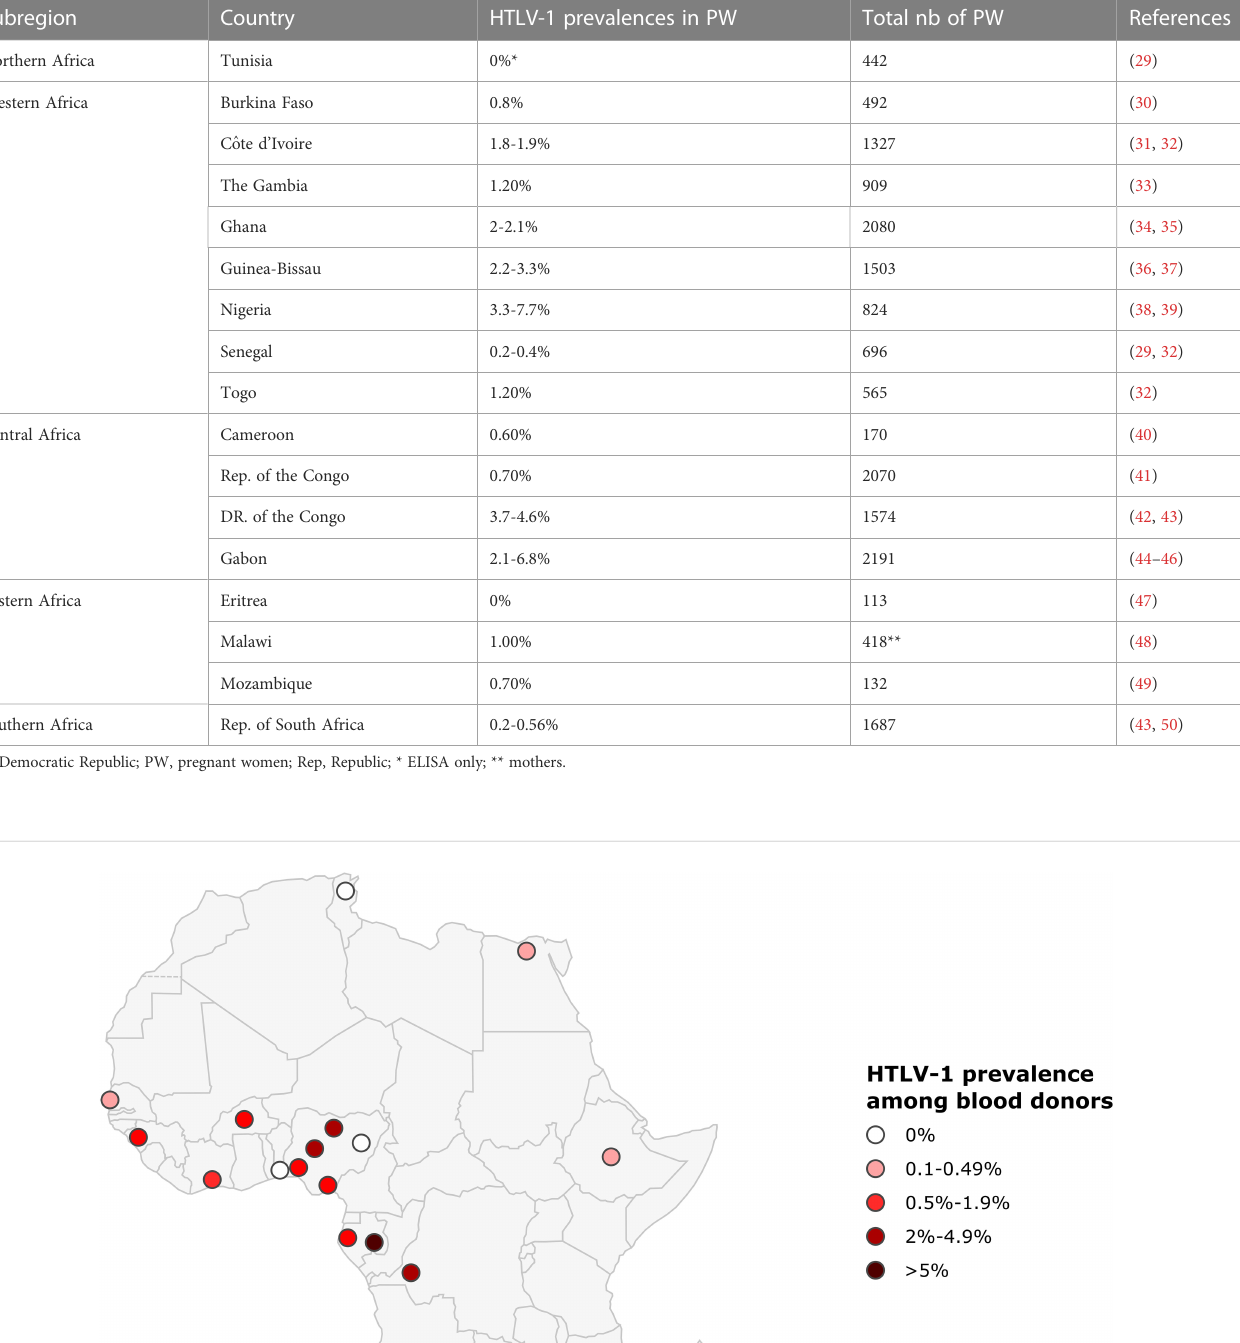
TABLE 1 HTLV-1 prevalence among African pregnant women.